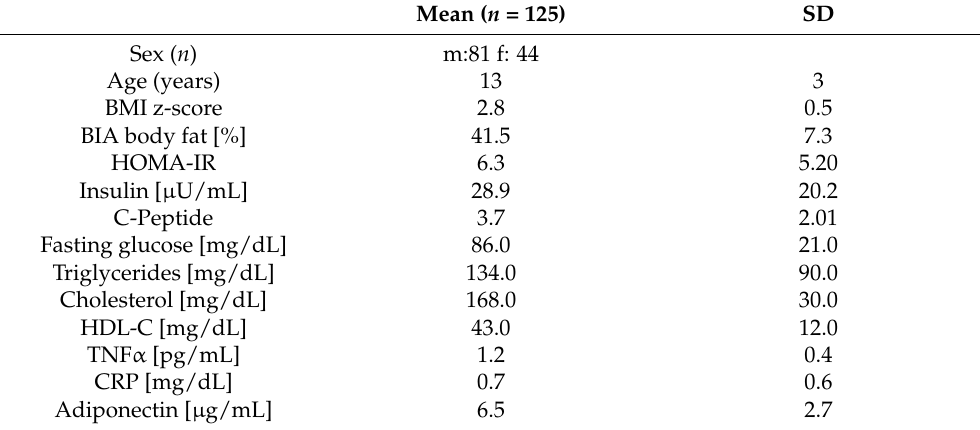
Table 1. Patient